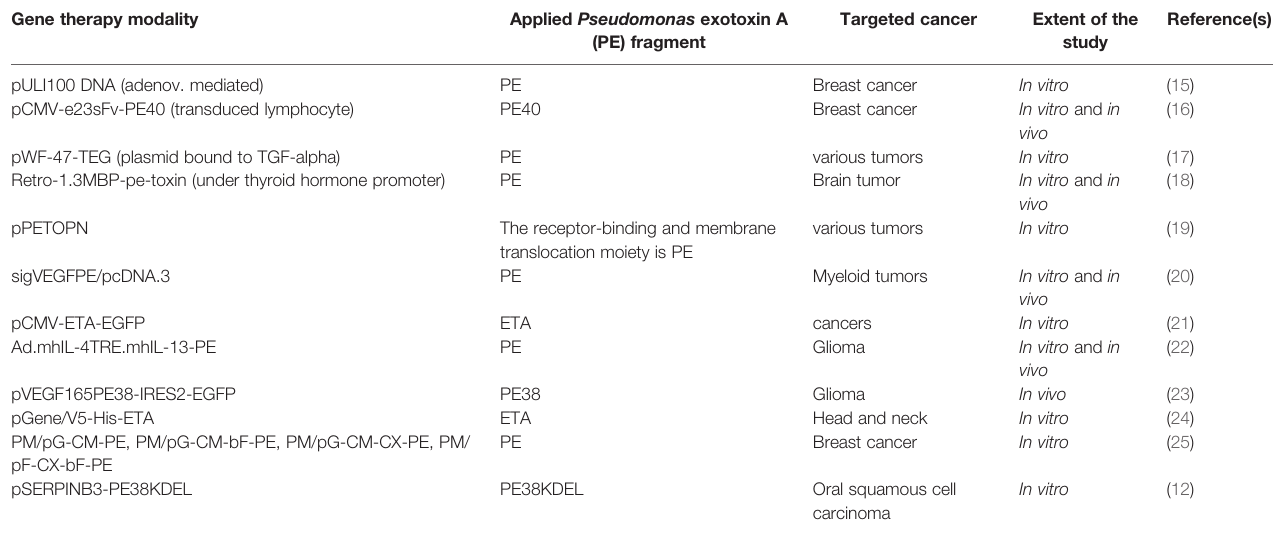
TABLE 1 | A summary of studies on gene therapy applications of Pseudomonas exotoxin A or its derivatives usually encoded under the control of a tumor-speci fi c promoter for targeted killing of corresponding cancer cells. Gene therapy